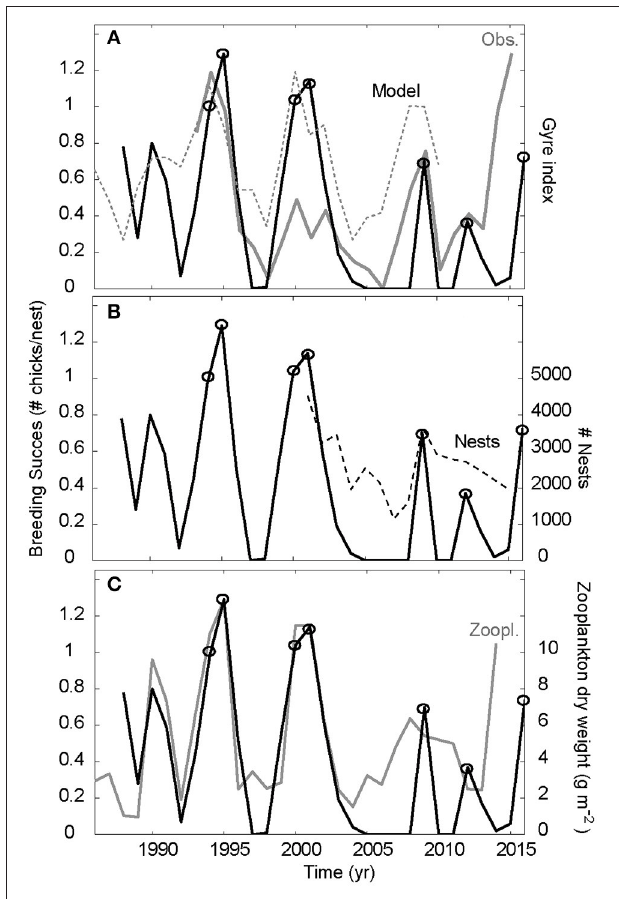
FIGURE 3 | Synchrony between east and west. The Faroe kittiwakes breeding success with full line in all three panels. This is compared to (A) the detrended observed (gray) and simulated (dashed) gyre index, (B) the number of nests in the colony (dashed) and (C) the south Iceland zooplankton abundances (gray). Cold periods with deep convection are associated peaks in the gyre index. The year with peaks in breeding success (1994–1995, 2000–2001, 2009, 2012, and 2016) are highlighted with open